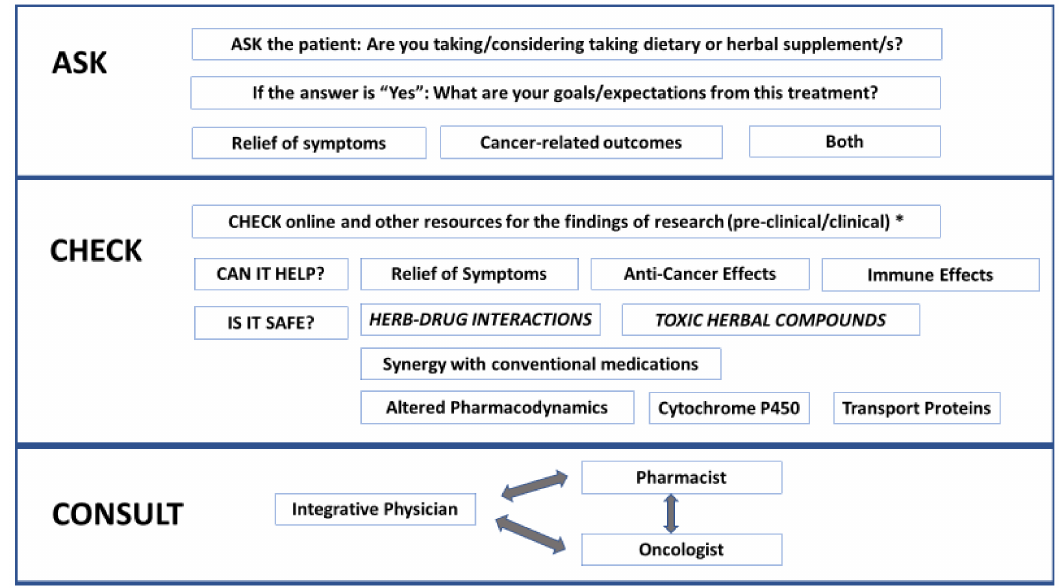
Figure 1. Algorithmic approach to addressing the use of herbal medicine by oncology patients (* di ff erentiate between potential herb–drug interactions reported in preclinical research from actual interactions observed in the clinical